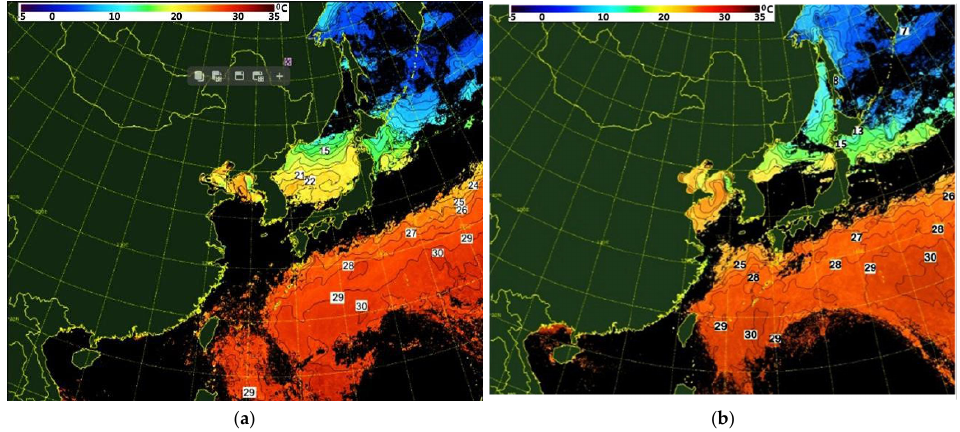
Figure 11. As shown in Figure 6, except recorded at ( a ) 09:00 LST, 6 July 2015, and ( b ) 09:00 LST, 7 July Long black areas indicate cloud bands in the MLCT. STS Linfa moved to the northern South China Sea of 31 °C SST near Macao passing by Luzon island. TY Chan ‐ Hom moved over the Kuroshio current to the northeast of the Philippines of 31 °C SSTs, drawing STS Linfa and the MLCT. In contrast to TY Chan ‐ Hom, the central pressure of TS Linfa increased by 7 hPa to 992 hPa on 6 July, reducing its maximum surface wind from 27 ms − 1 to 23 ms − 1 due to the frictional effect of land including China, Taiwan Island, and the shallower sea bottom close to the coast (Table 1, Figure 9b). At the same time, as the westward movement of TY Chan ‐ Hom was influenced by the MLCT, its resulting movement was more to the north ‐ west, thereby decreasing the distance between STS Linfa and TY Chan ‐ Hom. This allowed TY Chan ‐ Hom to disrupt Linfa’s cyclonic circulation in its right upper quadrant and reduce surface wind speeds. Thus, as shown in Figure 10b, by the interaction of a stronger TY Chan ‐ Hom connecting with the circulation of STS Linfa, Linfa was steered northwestward toward the Shantou area of Guangdong province in southern China. By 09:00 LST, 7 July, TY Chan ‐ Hom, having been steered northward by the MLCT over the area of 30~31 °C SST influenced by the Kuroshio current, had intensified by 5 hPa down to 975 hPa central pressure and maximum surface wind speed of 32 m/s in its the right ‐ upper quadrant (Figures 11b, 12, and 13). On the other hand, STS Linfa moving slowly at 4 km/h intensified by 7 hPa from a central pressure of 992 hPa to 985 hPa, and the maximum surface wind speed increased to 27 m/s.